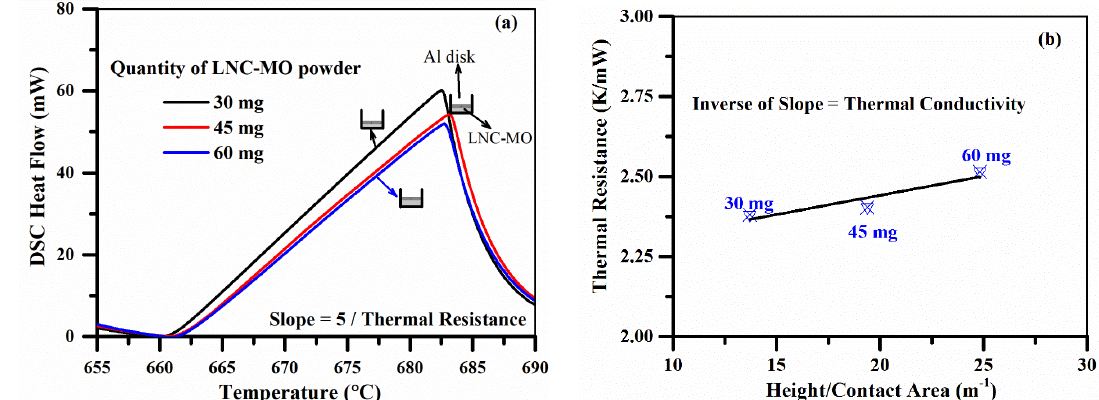
Figure 3. ( a ) The endothermic peak (segment 8—Al disk melting) of measurements with different quantity of LNC-MO, ( b ) The plot is used to estimate the absolute thermal conductivity.